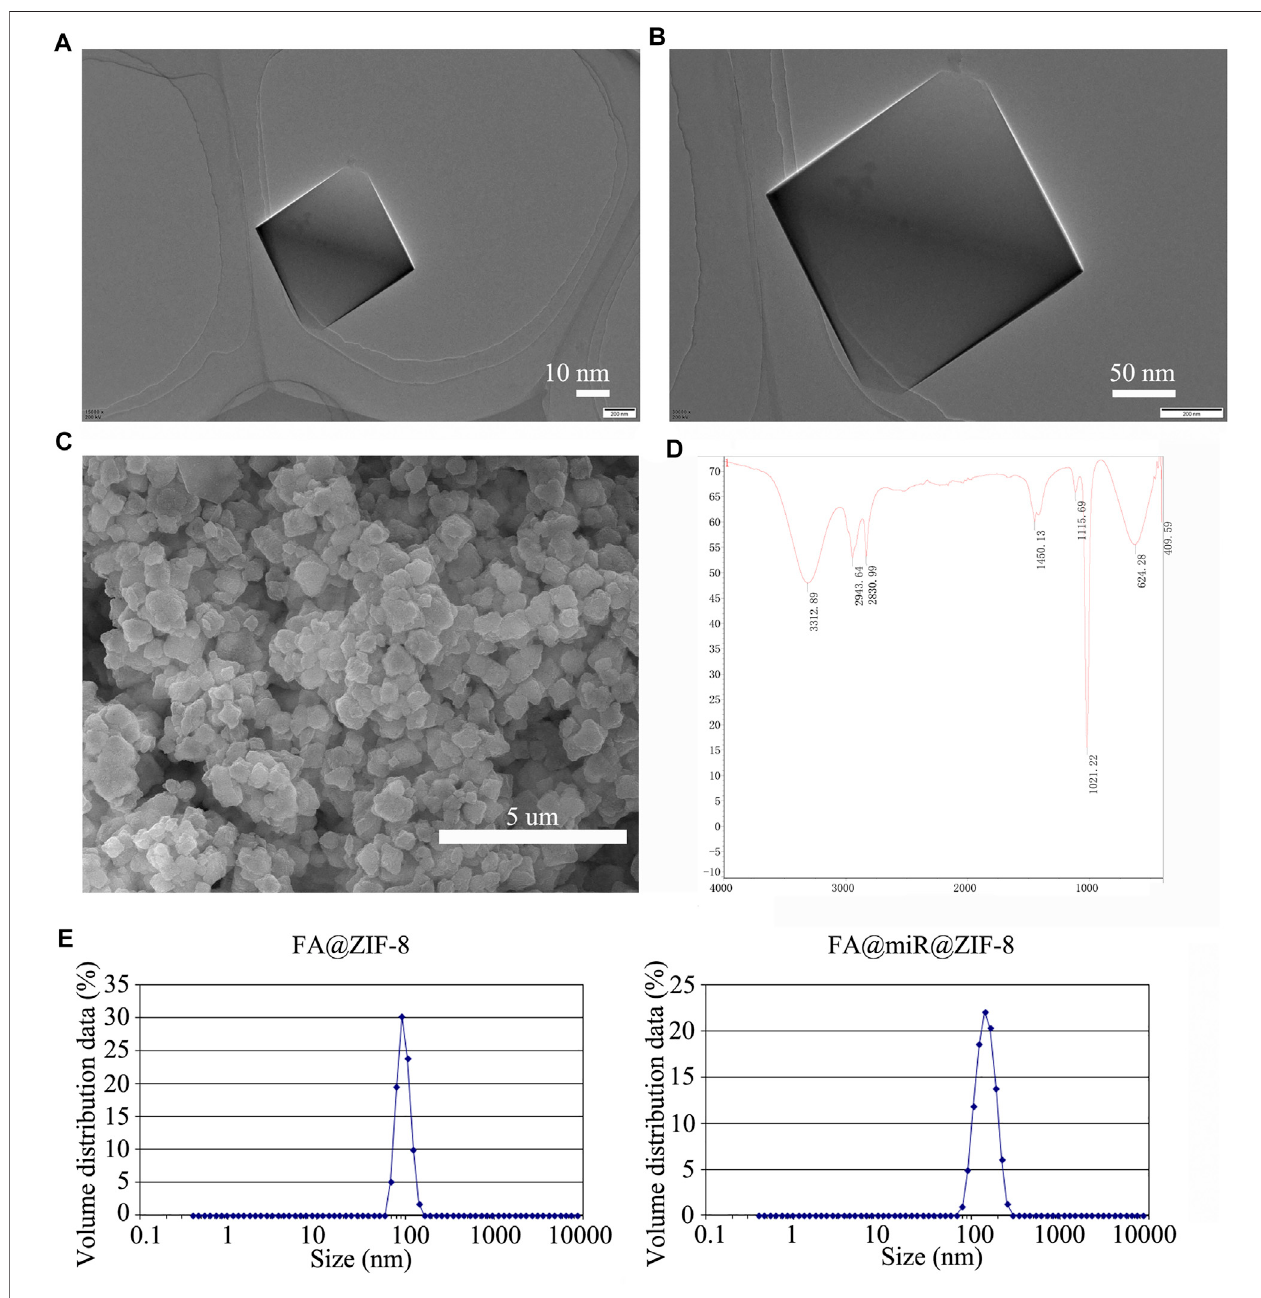
FIGURE3| PreparationandcharacterizationofFA@ZIF-8 – basednanoparticles. (A,B) TEMimagesofZIF-8nanoparticles. (C) ZIF-8hadauniformsurface,andthe diameter ofZIF-8 wasapproximately 100 – 150 nm. (D) FT-IRspectrumofFA@miR@ZIF-8 nanoparticles. (E) Dynamic lightscattering (DLS) wasused totest the particle